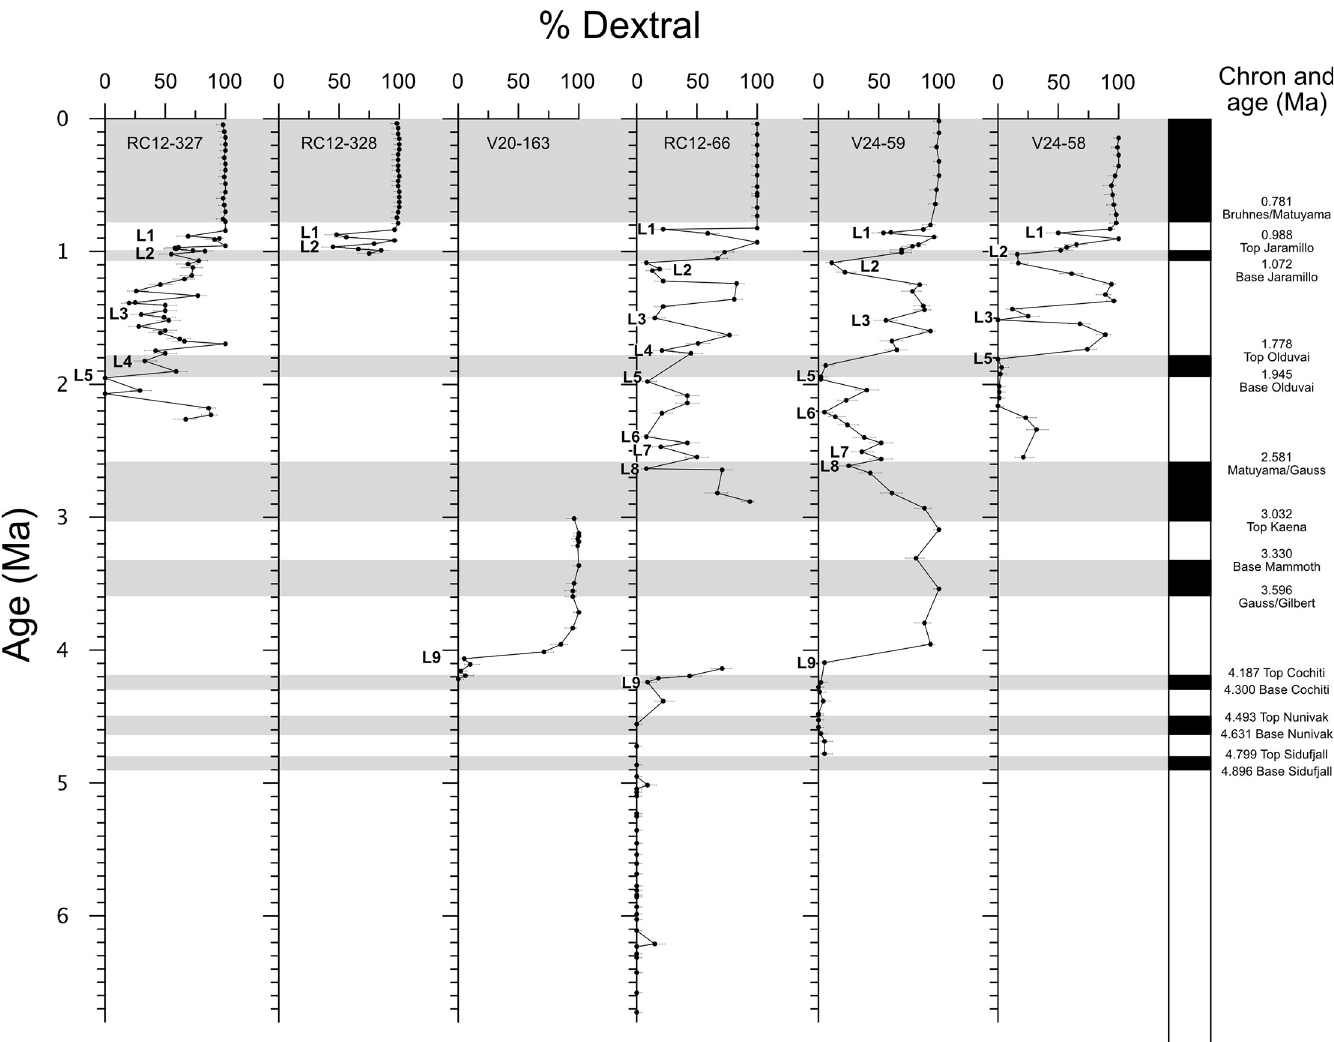
Fig 5. Saito’s ‘L’ events in six Indo-Pacific cores. For locations see Fig 4. Redrawn from Ref. [46] on a modern timescale and with sampling error bars added. Error bars represent 95% confidence intervals about the measured proportion. Labels for ‘L’ events are placed close to where they were originally indicated in